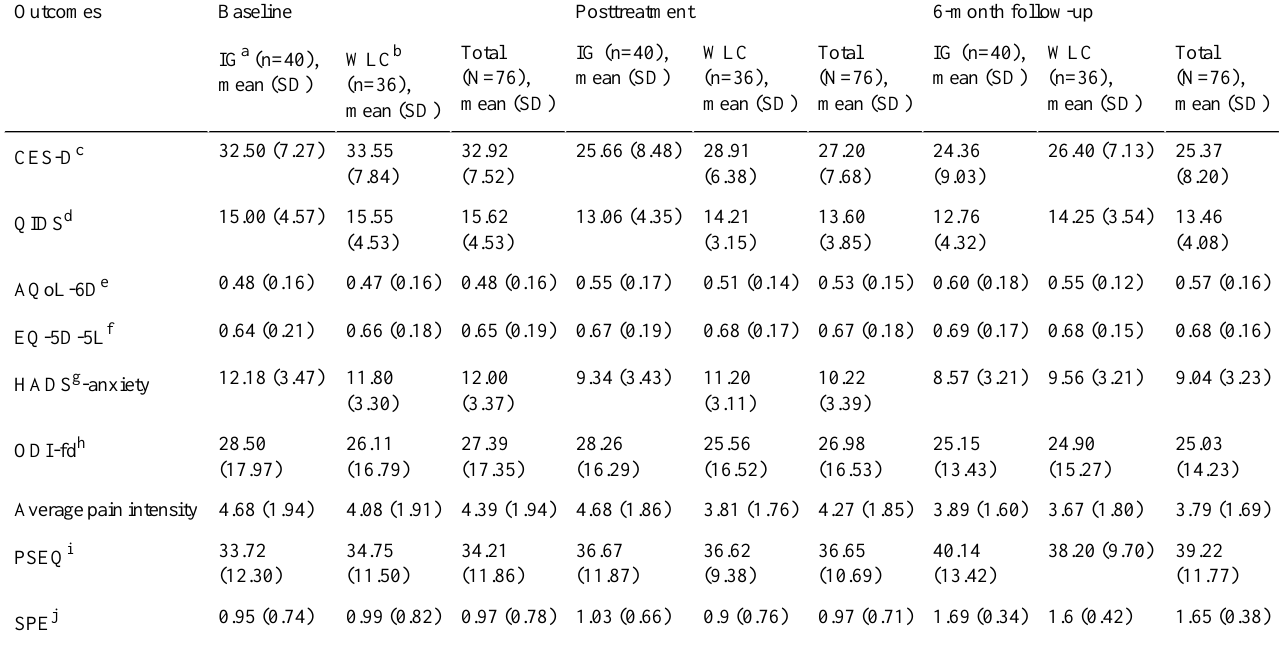
Table 4. Mean (SD) of outcomes.